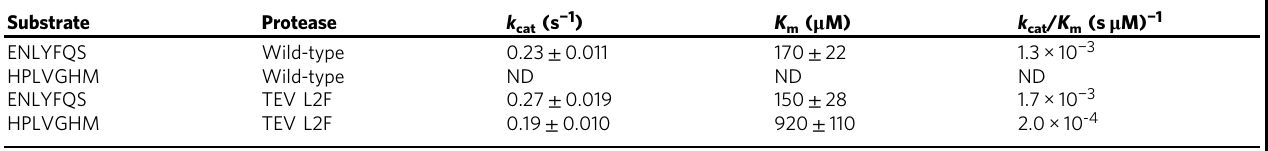
Table 2 Kinetic parameters of wild-type and evolved TEV proteases Substrate